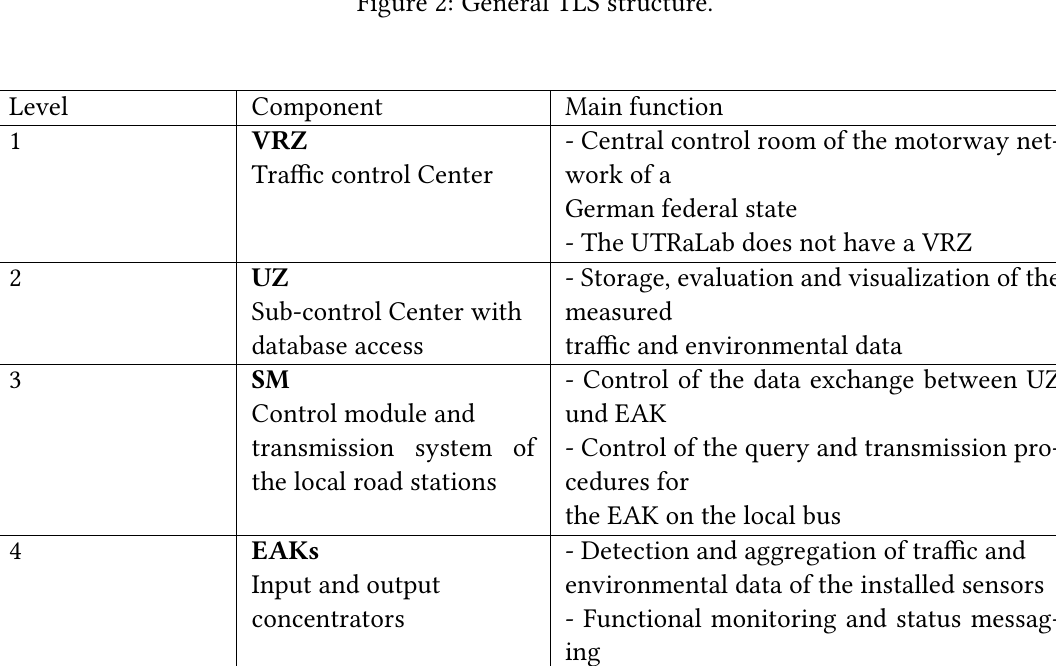
Figure 2: General TLS structure.